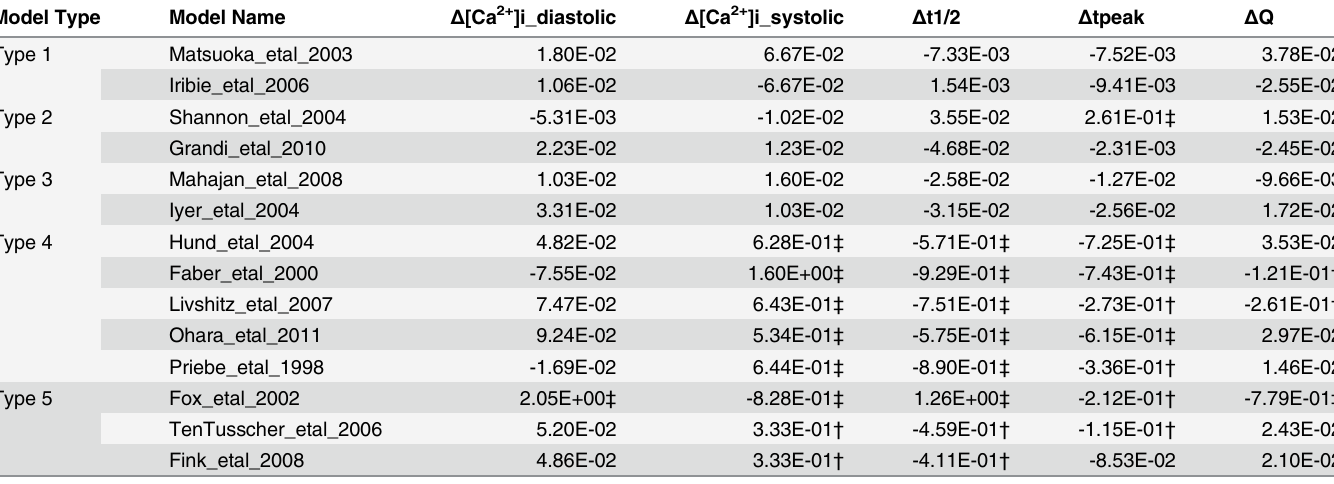
Table 7. Data for steady priming beat: relative differences between EP models and models with NL96 contractions. Model